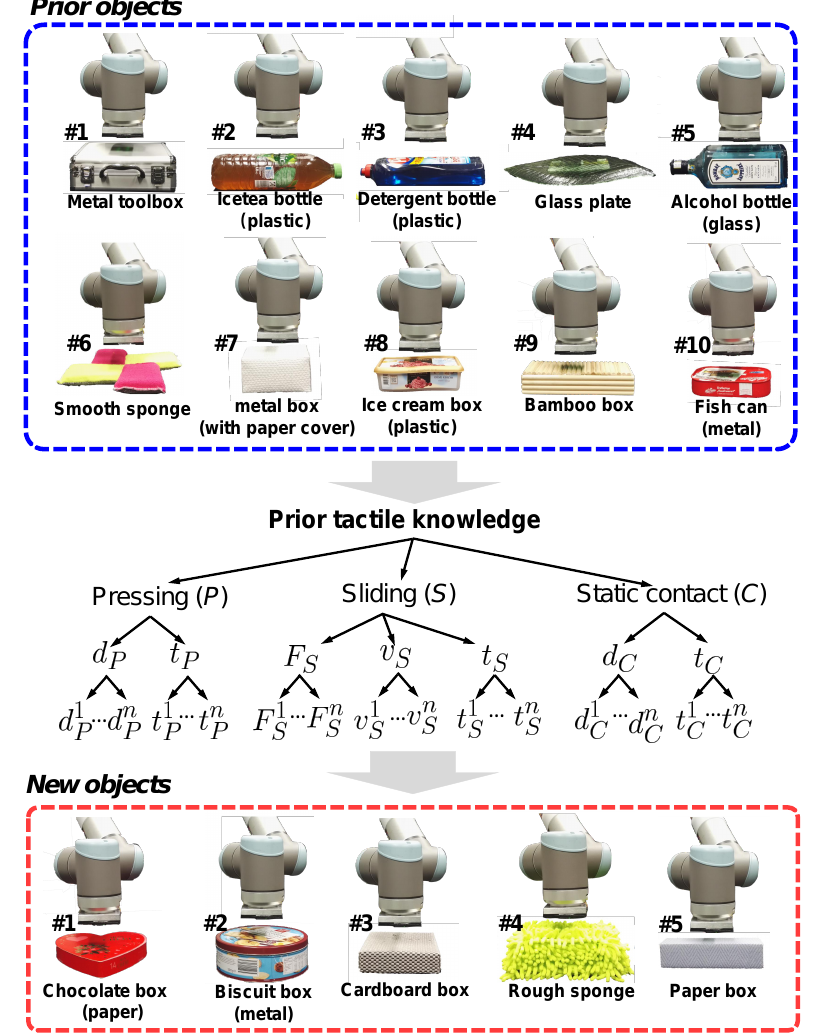
Figure 1. The robot leverages the prior tactile exploratory action experiences built by applying the pressing, sliding, and static contact movements with different action parameters on the prior objects (with index #1–#10) to learn about new objects’ (with index #1–#5) physical properties. The feature observations of prior objects (prior tactile instance knowledge) were used to transfer the action